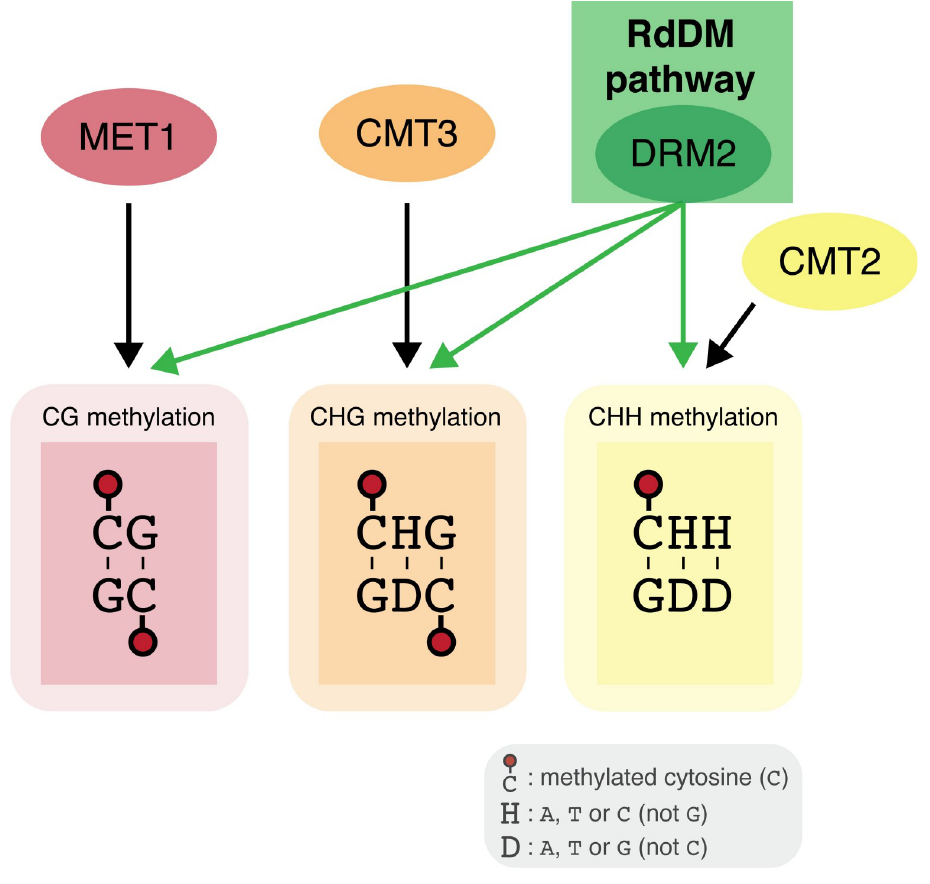
Fig 2. DNA methylation sequence contexts and related DNA methyltransferases. DNA methylation at cytosines followed by guanines (CG methylation) is maintained by MET1, while CHG and CHH methylation are maintained by CMT3 and CMT2, respectively. The methyltransferase involved in RdDM, DRM2, can add DNA methylation regardless of sequence context.